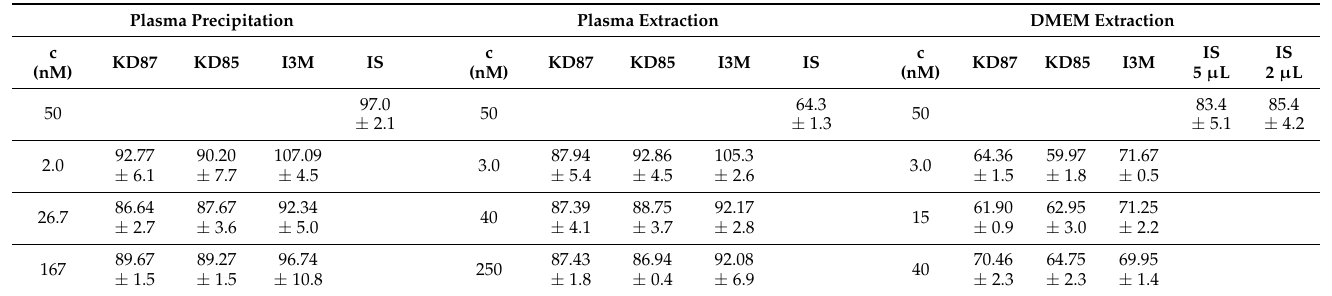
Table 5. Recovery of the analytes KD87, KD85, I3M, and the internal standard (IS) after plasma precipitation, plasma extraction, or DMEM extraction. Values are mean percentages ± standard deviation (SD) of n = 3–5.